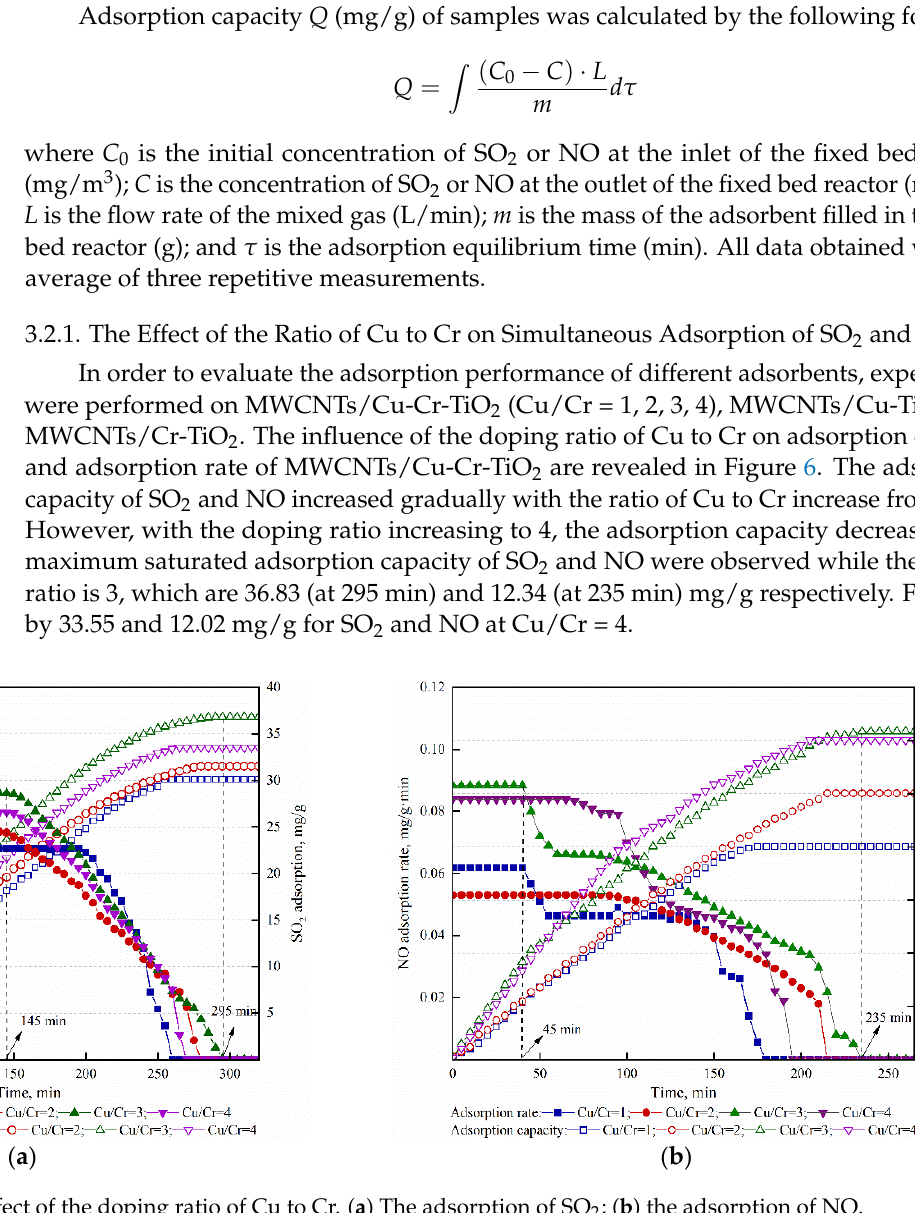
2 ; ( b ) the adsorption of